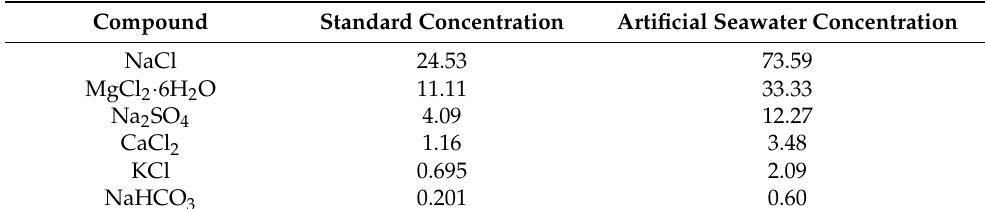
Table 5. Chemical Composition of artificial seawater, (g/L).